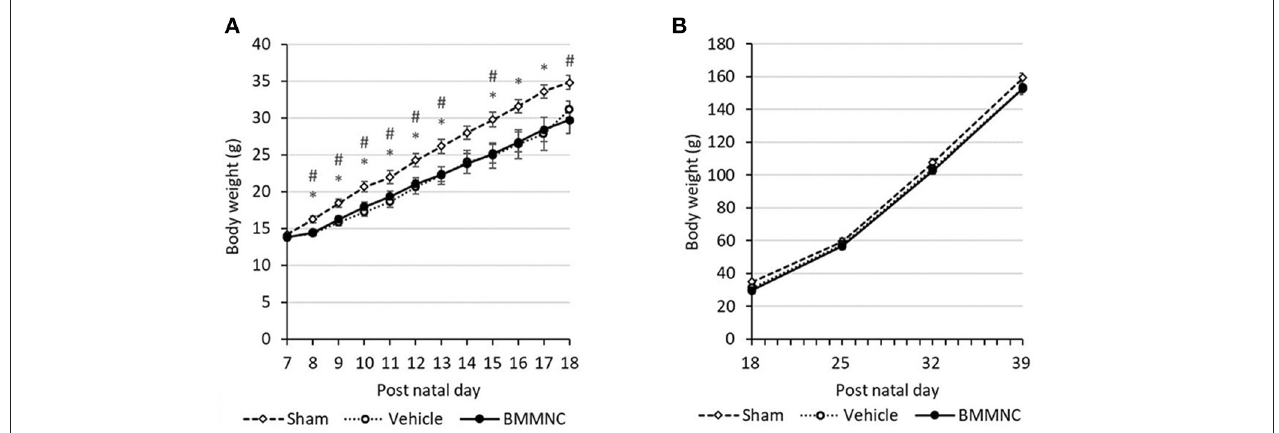
FIGURE 2 | Average weight gain during the acute (A) and chronic (B) phases. From P8 to P13, the BMMNC and vehicle groups differed significantly from the sham group. No significant difference was observed between the BMMNC and vehicle groups. Open squares and dashed line: sham, n = 9; open circles and dotted line: vehicle, n = 9 (P7–P17) and 8 (P18–P39); closed circles and solid line: BMMNC, n = 9 (P7–P20) and 8 (P21–P39). *Sham vs. Vehicle, p < 0.05; # Sham vs. BMMNC, p < 0.05; Student’s t -test.